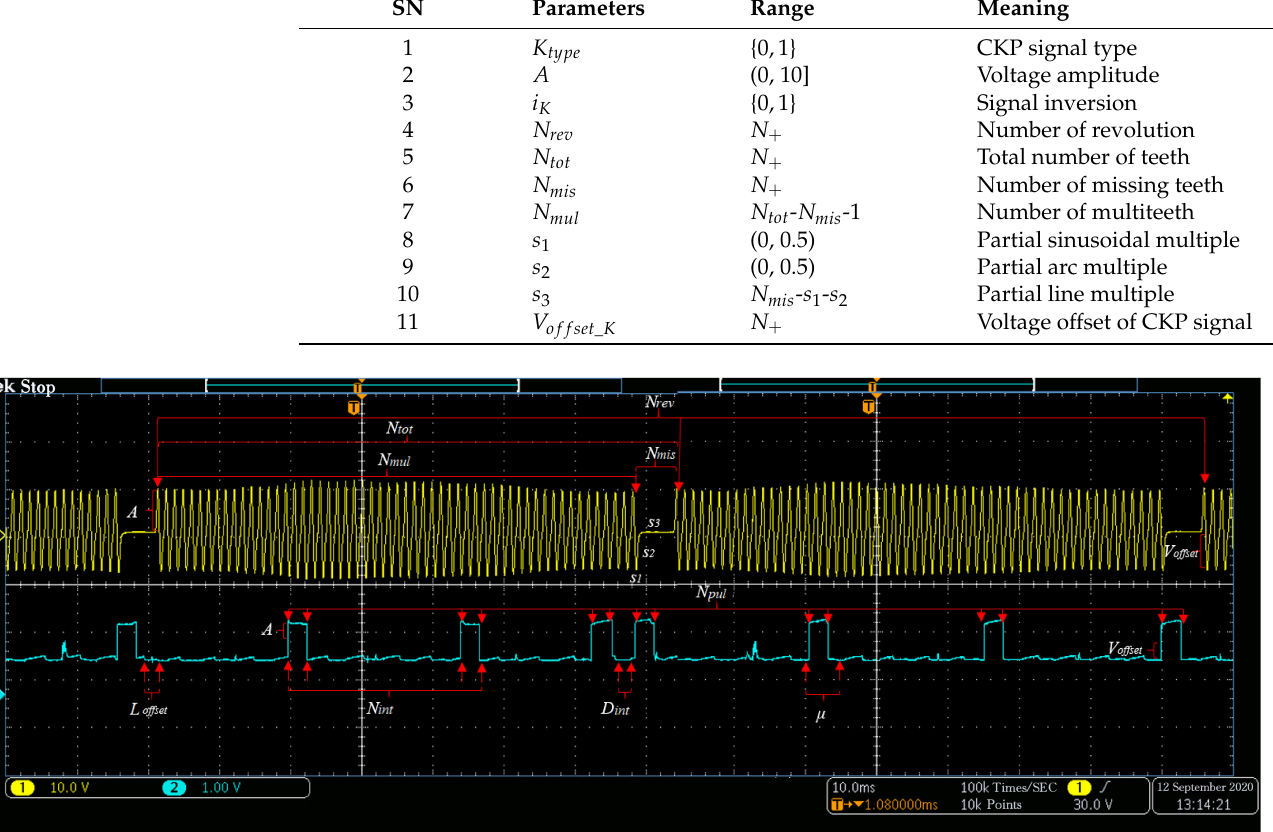
Figure 2. The CKP and CMP signal parameters diagram. The yellow curve represents the actual collected CKP signal. The blue curve represents the actual collected CKP